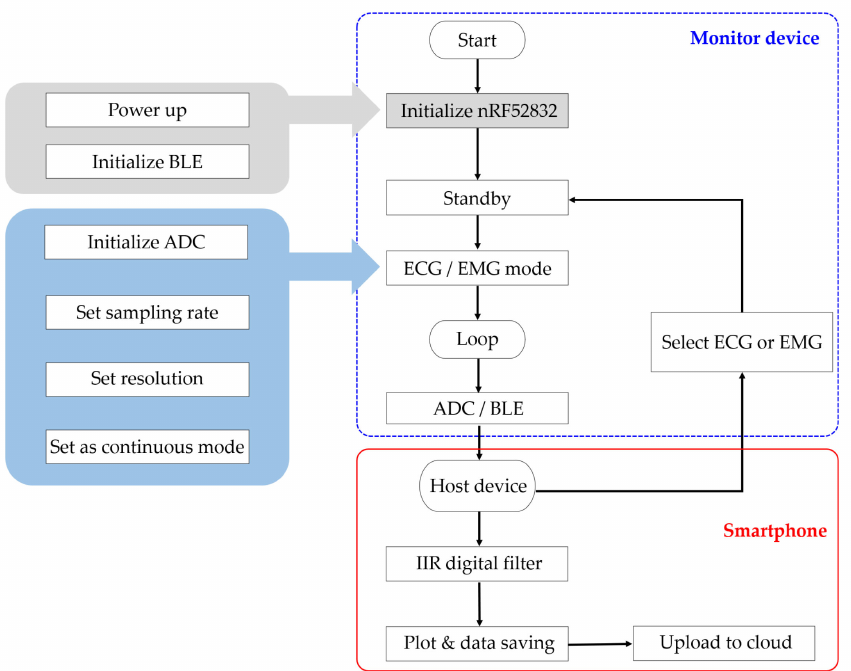
Figure 3. Flow chart of the proposed ECG monitoring system. Upon power up, the microcontroller initializes the BLE for standby. The host device pairs with the monitor device for mode selection (ECG, EMG). Once the measurement mode has been selected, the monitor device samples the incoming analog signal and transmits the data to the host device. The host device performs an additional filtering and displays a real-time plot. The data are saved in the local device and uploaded to cloud server for further